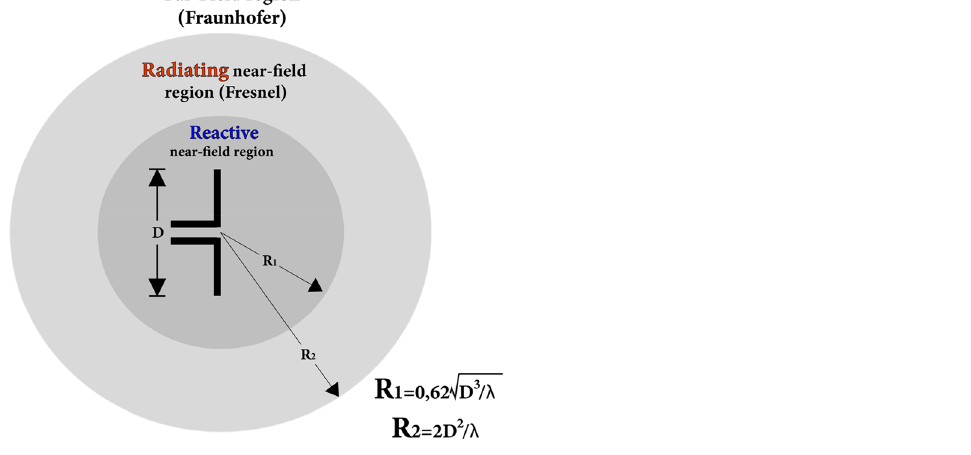
Figure 17. Near field and far field